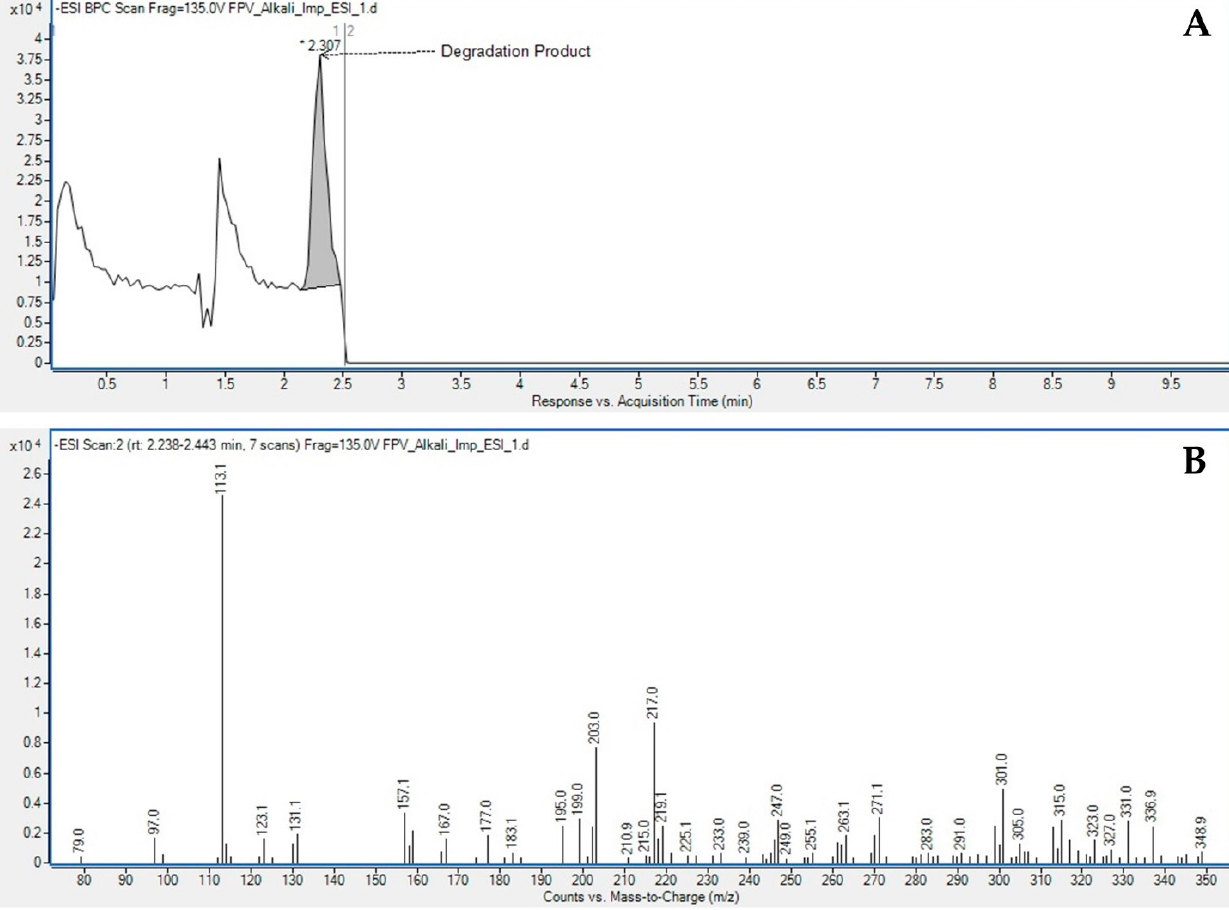
Figure 5. Base peak chromatogram ( A ); precursor ion scan ( B ); product ion scan ( C ) of alkali degra- dation sample using LC ‒ MS/MS.